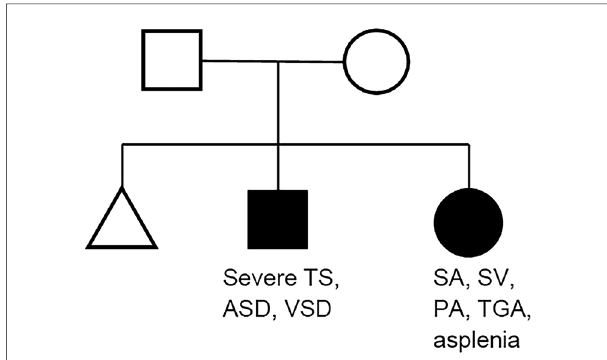
FIGURE 1 Pedigree chart of the family. TS, tricuspid valve stenosis; ASD, atrial septal defect; VSD, ventricular septal defect; SA, single atrium; SV, single ventricle; PA, pulmonary atresia; TGA, transposition of the great arteries.